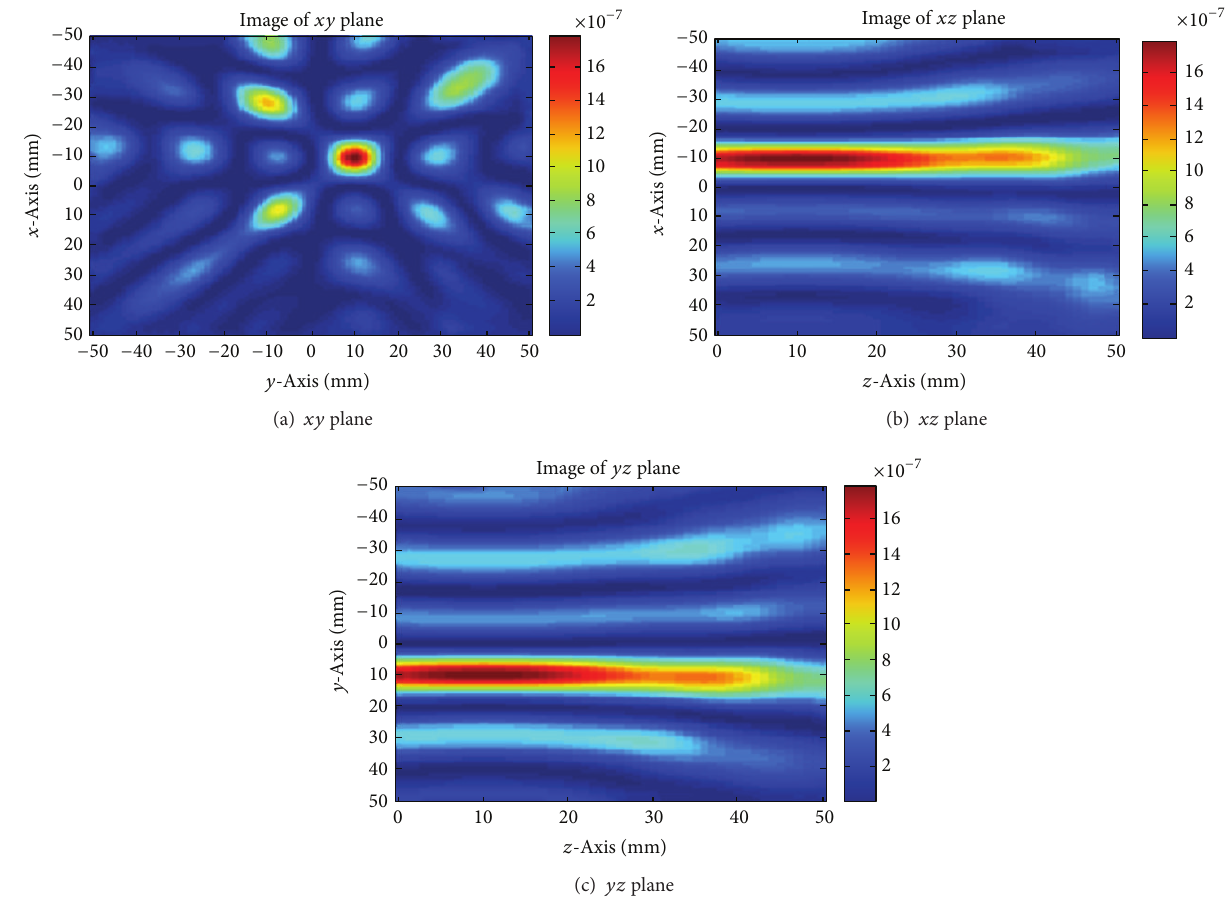
Figure 10: Breast image through addition of tumour